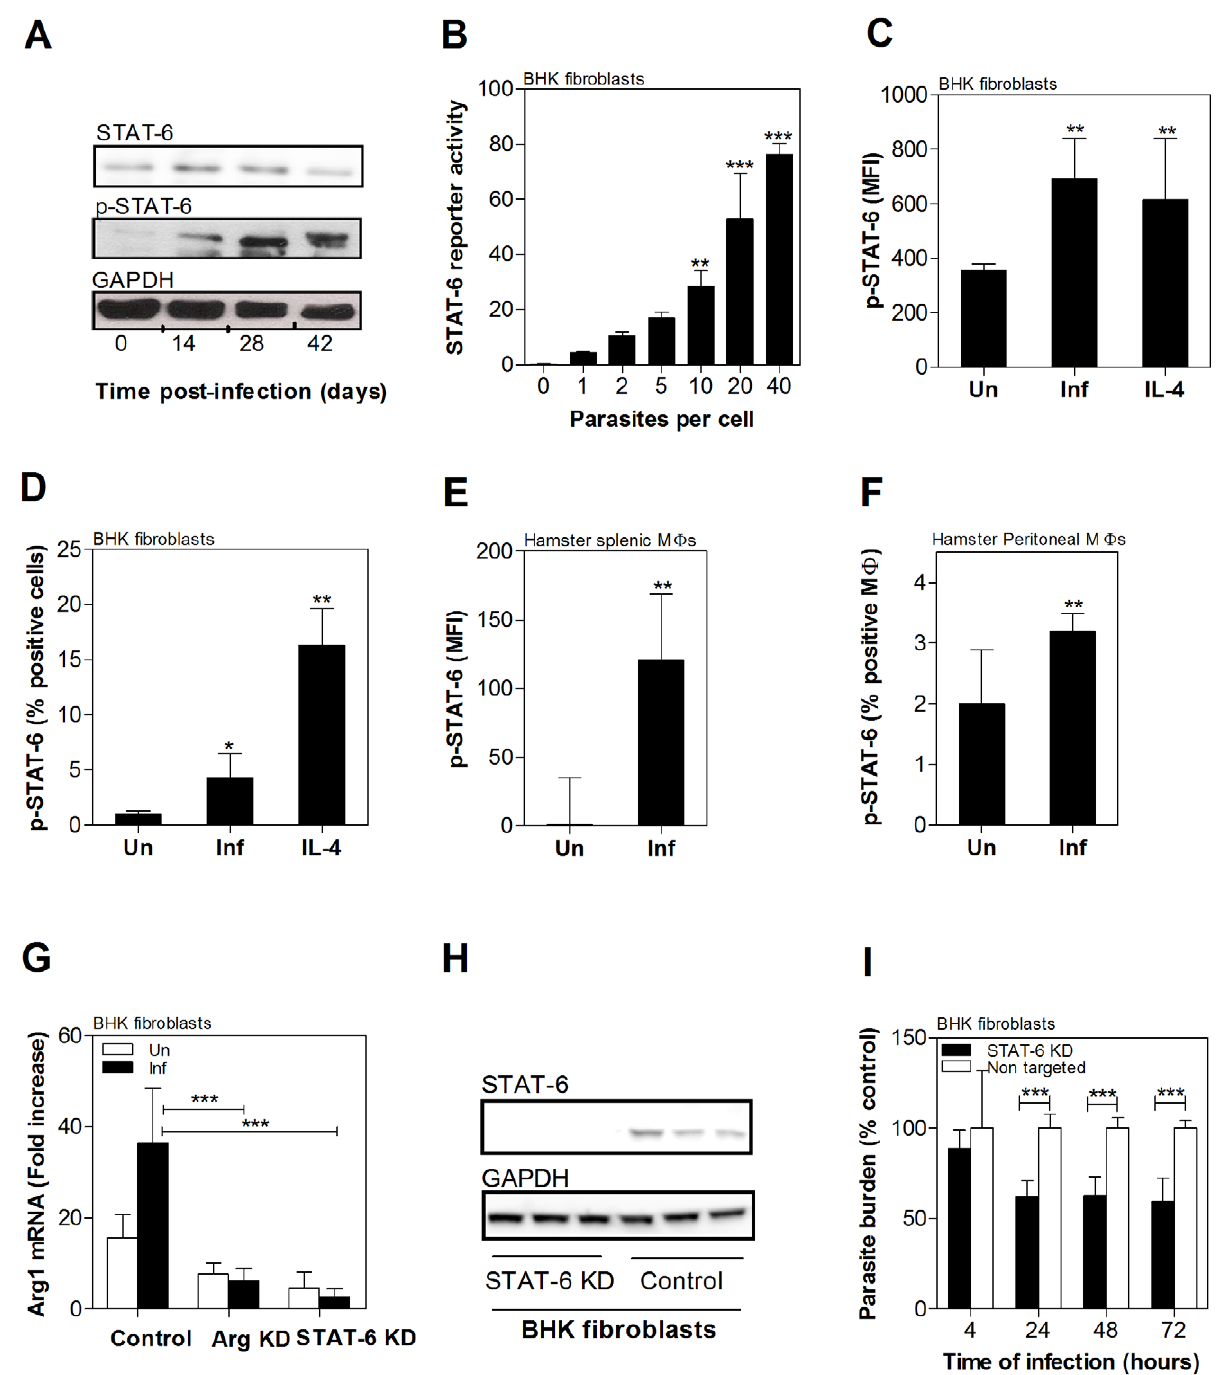
Figure 7. Role of parasite-induced STAT6 activation in host arg1 expression and L.donovani infection. A ) Phosphorylated STAT6 in spleens of hamsters infected with L. donovani determined by immunoprecipitation followed by western blot of whole splenic lysates. The samples (before immunoprecipation) were probed with anti-STAT6 anti-GAPDH antibodies to confirm equivalent protein loading. The blot shown is from tissue from a single animal, representative of 4 independent experiments. B ) Dose-dependent induction of STAT6 activation by L. donovani in BHK cells transfected with a STAT6-luciferase reported vector. Data are presented as the mean and standard deviation (error bars) of the relative light units in uninfected (0 parasites) cells and cells exposed to 1–40 parasites per cell over 48 hrs of culture. Shown is data from a single experiment that is representative of 2 independent experiments. C-D ) Phosphorylation of STAT6 in hamster peritoneal macrophages exposed to L. donovani (10 parasites per cell) or IL-4 (10% v/v supernatants) measured as fold-increase of mean fluorescence intensity (MFI) ( C ) or percent positive cells ( D ) by flow cytometry. Data are presented as the mean and standard deviation (error bars) and are from a single experiment that is representative of 2 independent experiments. E–F ) Phosphorylation of STAT6 in hamster BHK cells exposed to L. donovani (10 parasites per cell) measured as fold- increase of mean fluorescence intensity (MFI) ( E ) or percent positive cells ( F ) by flow cytometry. Data are presented as the mean and standard deviation (error bars) and are from a single experiment that is representative of 2 independent experiments. G ) Effect of miRNAi-mediated STAT6